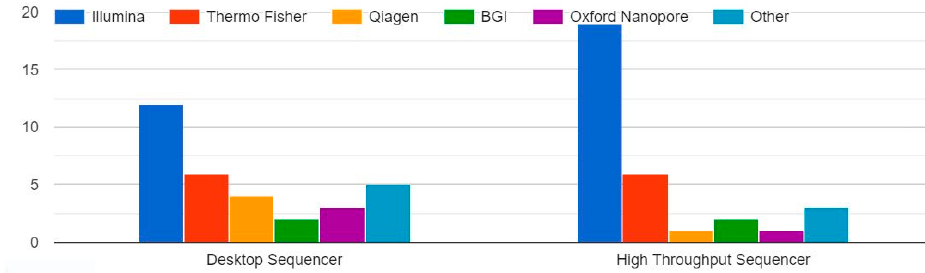
Figure 7. Sequencers used in routine practise in centres.